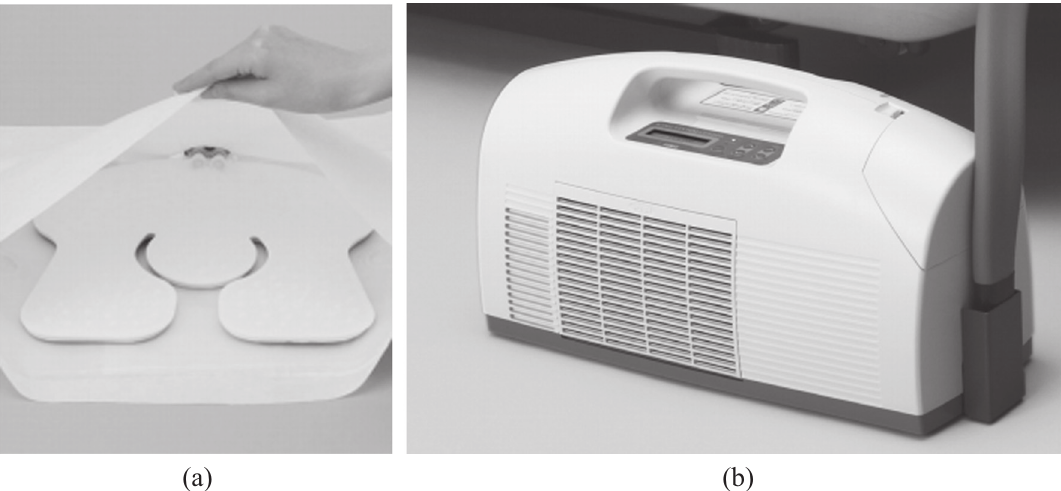
Figure 1. (a) A cooling pad (28 (cid:1) 29 cm) wrapped in a waterproof cover for the surgical wound and the thigh (Sigmax, Tokyo, Japan). (b) A computer-controlled cooling device (Icing System CF3000, Sigmax, Tokyo, (Table 1). The average age of all subjects at surgery was 67.9 ± 9.2 years. There were 58 women and 2 men. The preop-